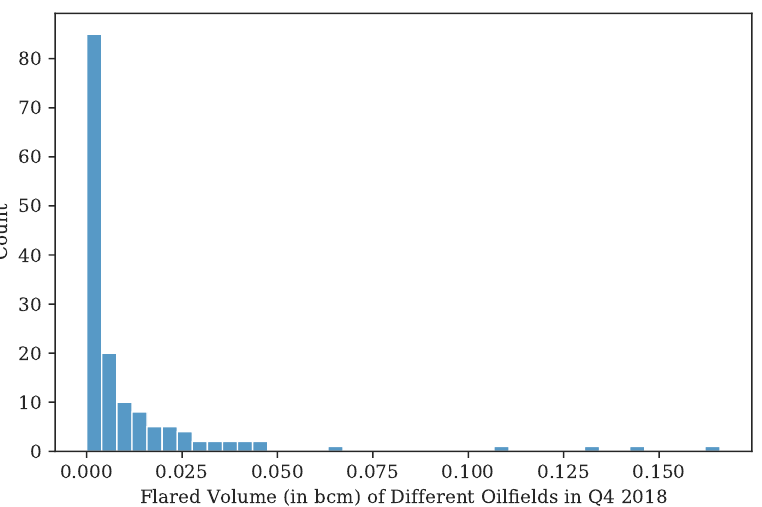
Figure 19. Histogram for the distribution of the field flared volumes from the fourth quarter of 2018. Most of the fields have comparatively small-scale flaring activities (e.g., less than 0.005bcm flared), while a few fields have volumes greater than 0.1bcm.